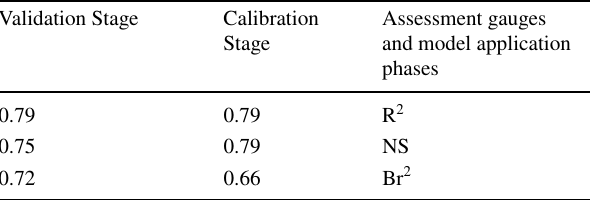
Table 1 Principles of runoff modeling assessment gauges in diverse stages of SWAT model